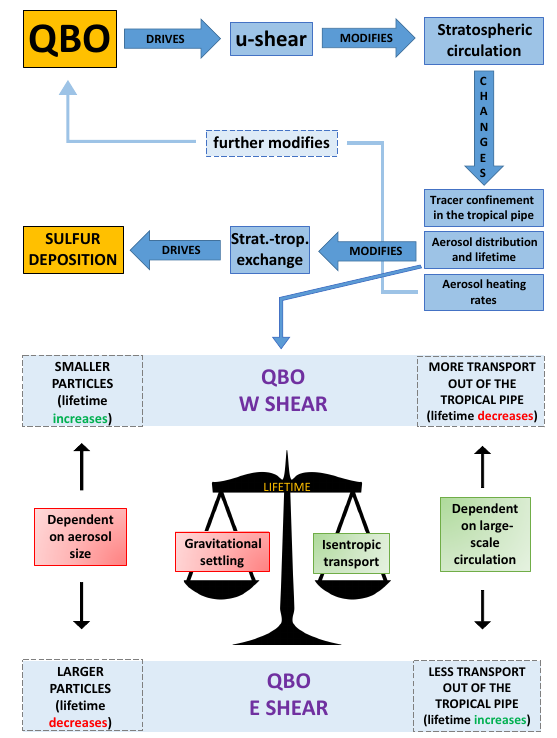
Figure 4. Upper part: schematic links between QBO, strato- spheric circulation, geoengineering aerosol lifetime, stratosphere– troposphere exchange, sulfur deposition at the surface. Lower part: schematic balance of the two main effects regulating the sulfate aerosol lifetime, starting from the driving QBO wind